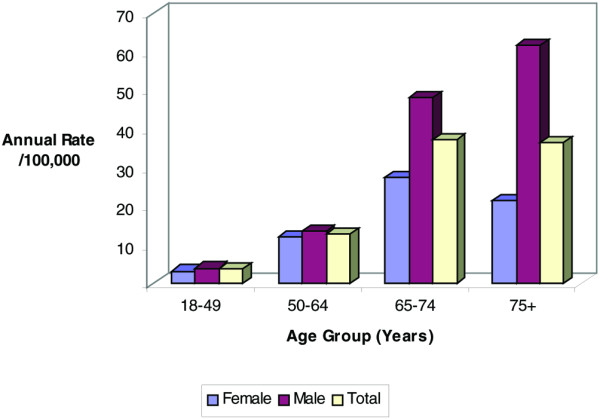
Age and sex-specific mortality rates of severe acute renal failure among adult residents admitted to a Calgary Health Region intensive care unit.